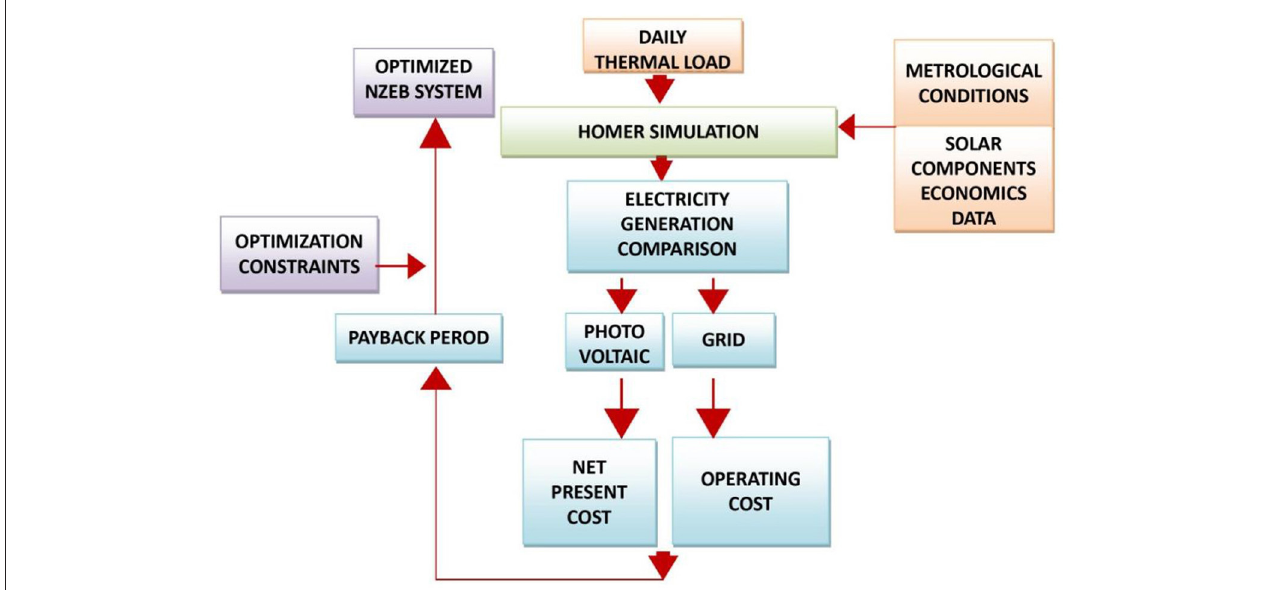
FIGURE 12 | Configuration of optimization of NZEB performance parameters.